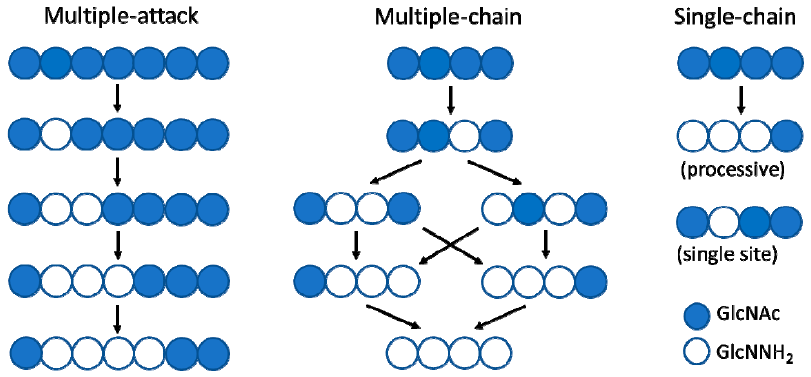
Figure 2. Modes of enzymatic action patterns for polysaccharide and oligosaccharide deacetylases: multiple-attack, multiple-chain, and single-chain mechanisms.